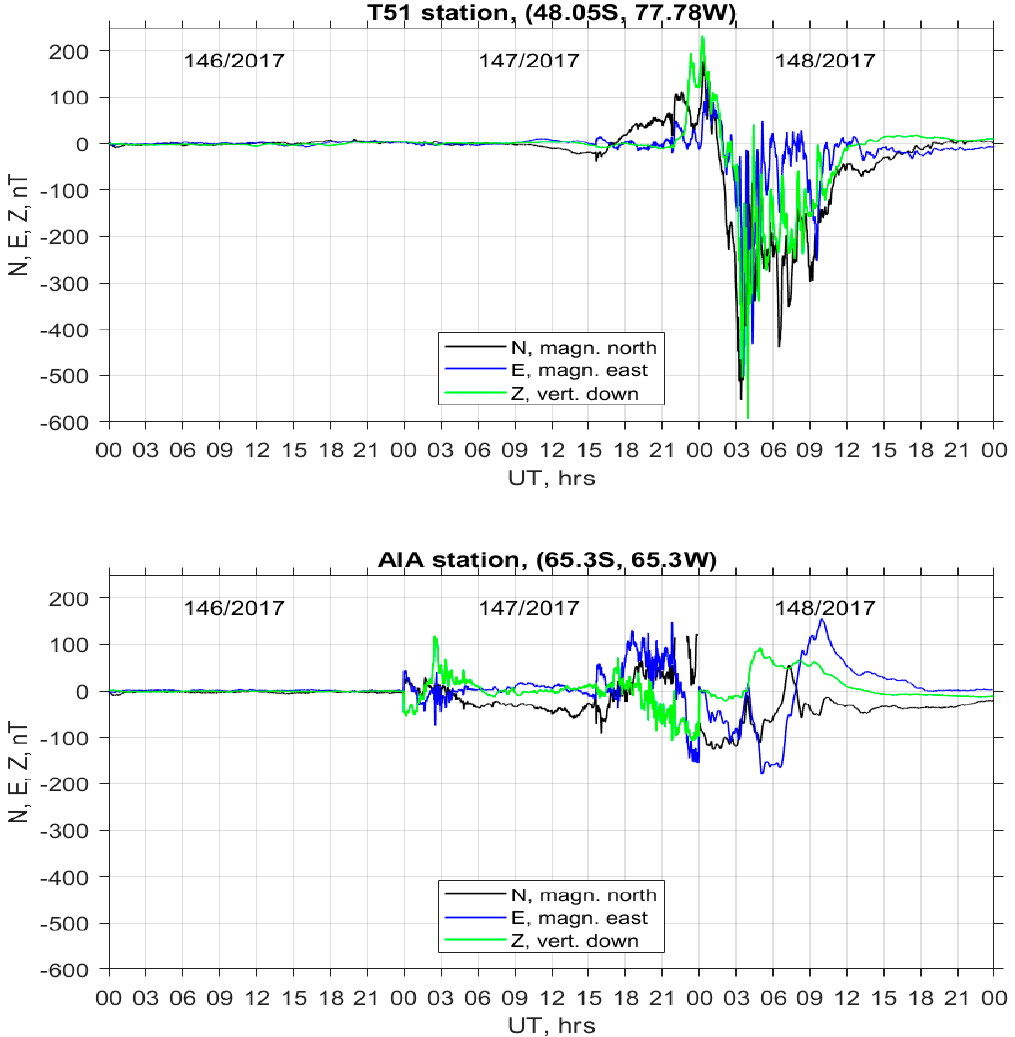
Figure 11. The top panel shows values of magnetic north, east, and vertical components during 26–28 May 2017 for the T51 magnetometer station located in the northern hemisphere (48.05°N, 77.4°W, Mlat: 57.0°N). The bottom panel shows values of magnetic north, east, and vertical components during 26–28 May 2017 for the AIA magnetometer station located in the southern hemisphere (65.3°S, 65.3°W, M.lat: 55.5°S).